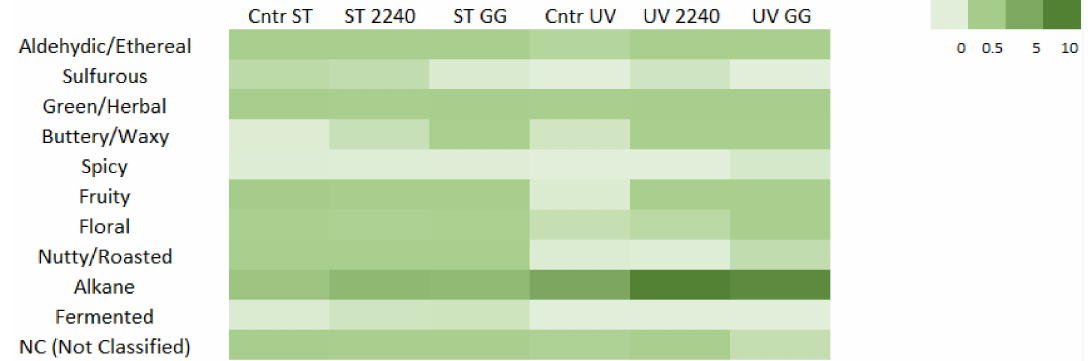
Figure 4. Heat map performed on the volatile concentration of volatiles grouped on the basis of their odor type detected in sterilized (ST) or UV-treated (UV) A. platensis biomasses fermented with L. casei 2240 (2240) and L. rhamnosus GG (GG) as well as treated but unfermented biomasses (Cntr). A scale ranging from a maximum of 10 µ g/g (dark green) to a minimum of 0 µ g/g (light green) was